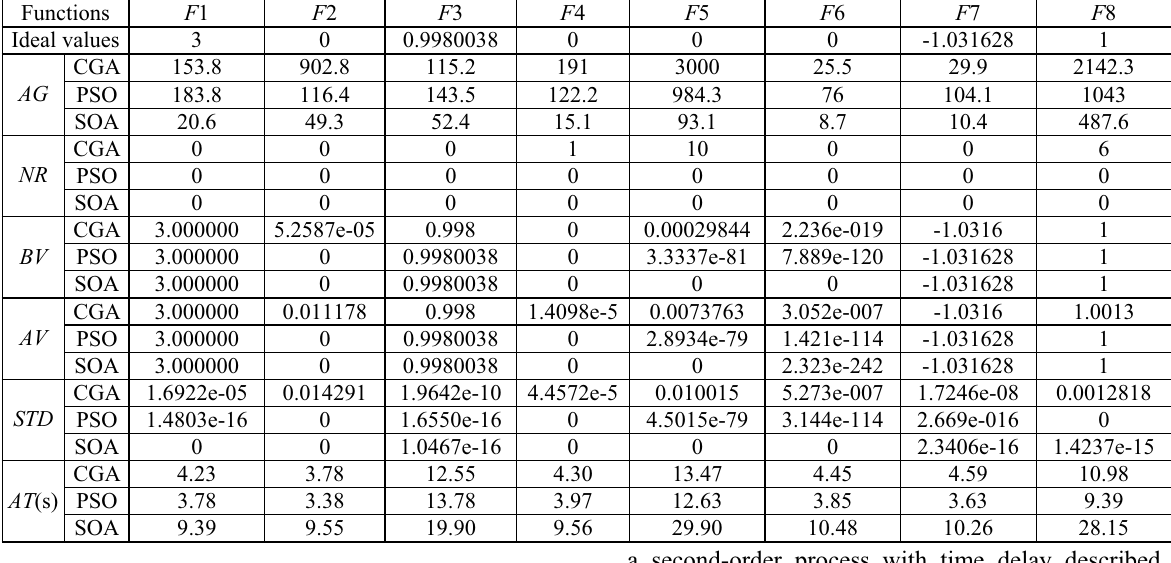
Table 1. Comparison of performances of SOA, CGA and